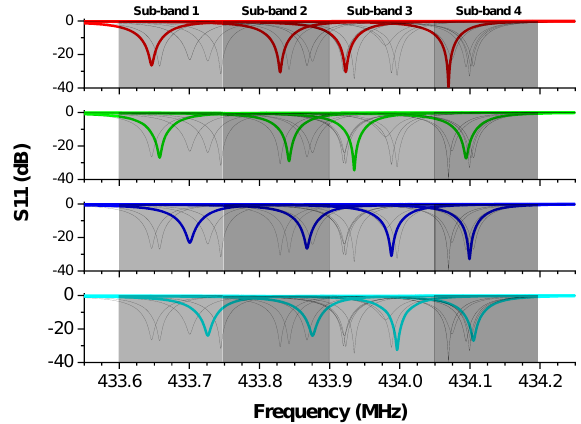
Figure 7. S11 response of every resonator on a single wafer. 4 × 4 sets of SAW resonators can be formed with at least 100 KHz frequency separation for each